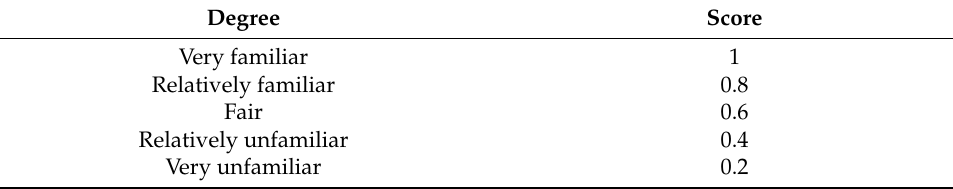
Table 2. Expert Familiarity Criteria.